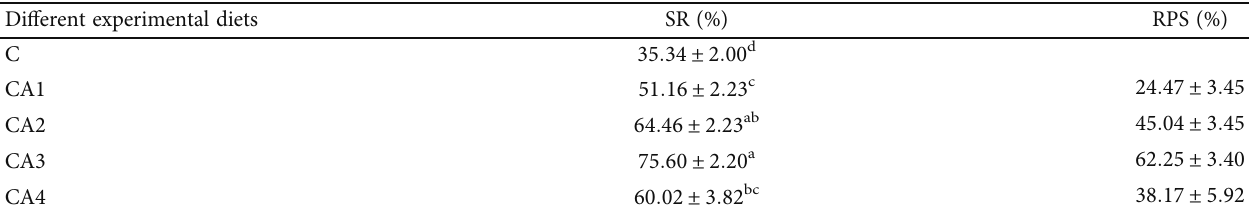
Figure 4: Mortality rate (%) of O . mykiss fed diets supplemented with di ff erent levels of ChA for 60 days after 14 days postchallenge with Y . ruckeri . Table 6: Survival rate and RPS (%) of O . mykiss fed diets supplemented with di ff erent levels of ChA for 60 days, at the end of the challenge with Y. ruckeri